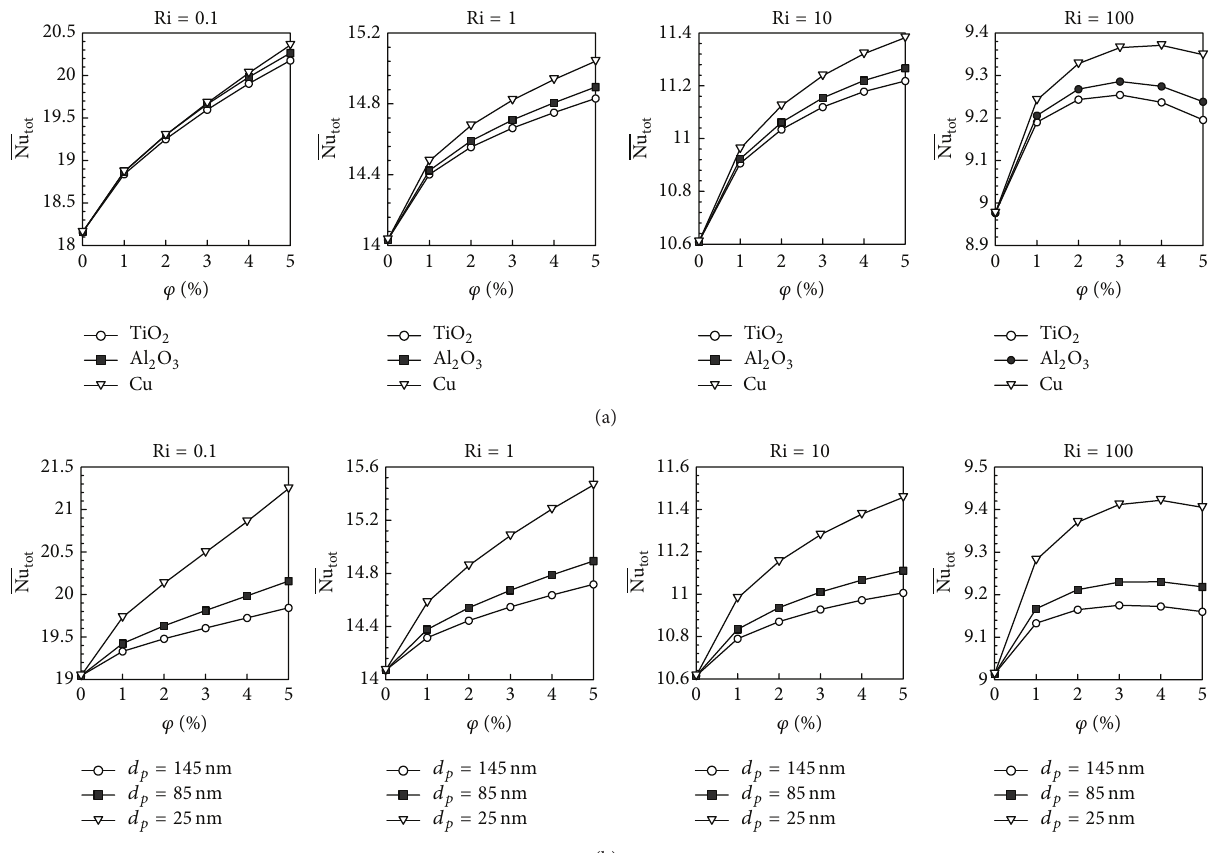
Figure 4: Variations Nu with respect to the volume fraction of the nanoparticles at different Richardson numbers, diameters, and type of tot nanoparticles for (a) Case 1 and (b) Case 2 . Gr = 10 4